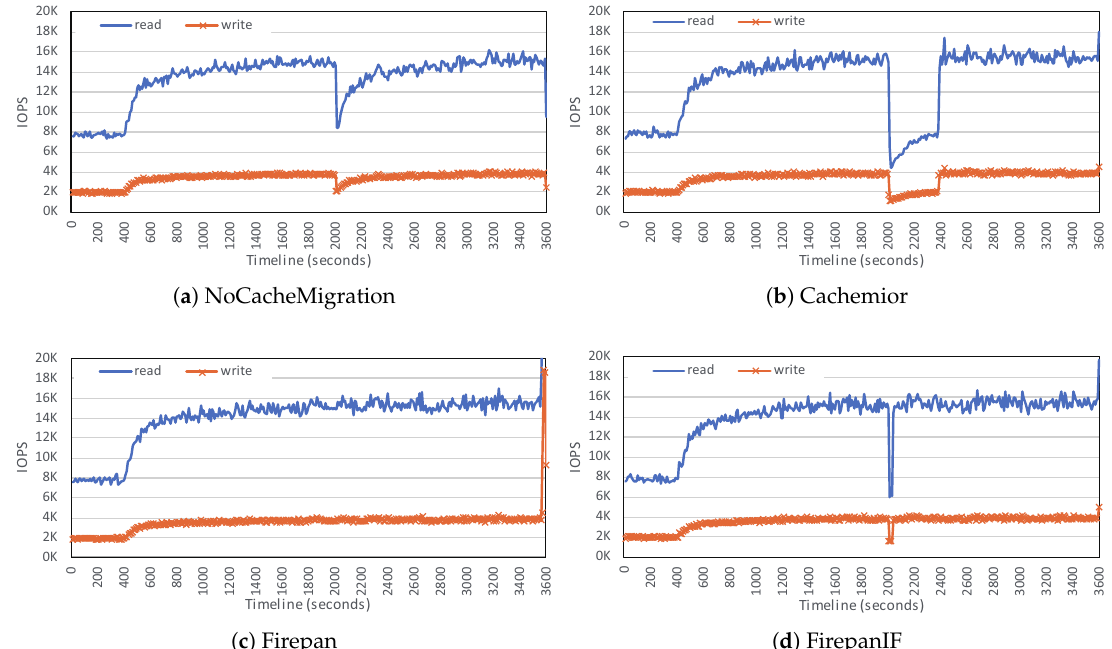
Figure 6. Performance of the target VM with NoCacheMigration, Cachemior, Firepan, and